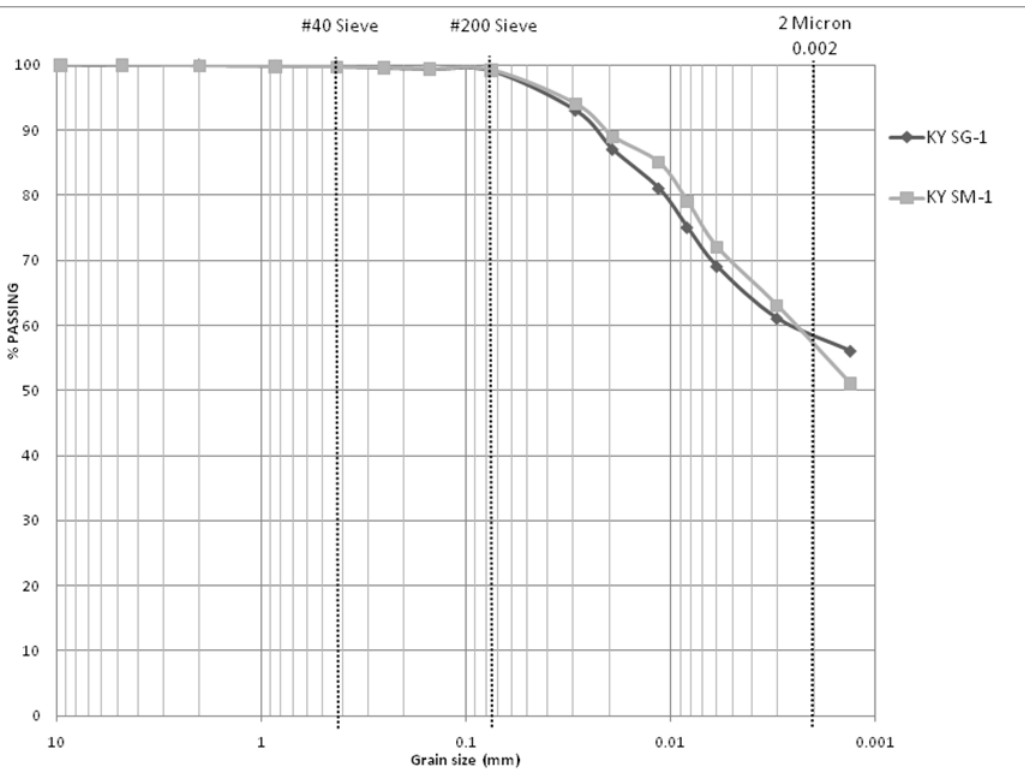
Figure 8. Comparison of grain size distributions: manually processed vs . grinder processed stockpiled samples of mined clay from Central Kentucky (KY SM-1 & KY